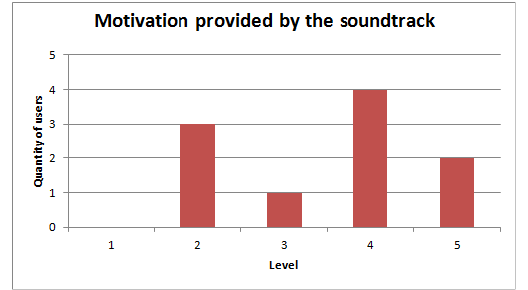
Figure 27. ViMeTGame evaluation question about the soundtrack. Scale: 1 to “Disagree”and 5 to “Fully agree”.